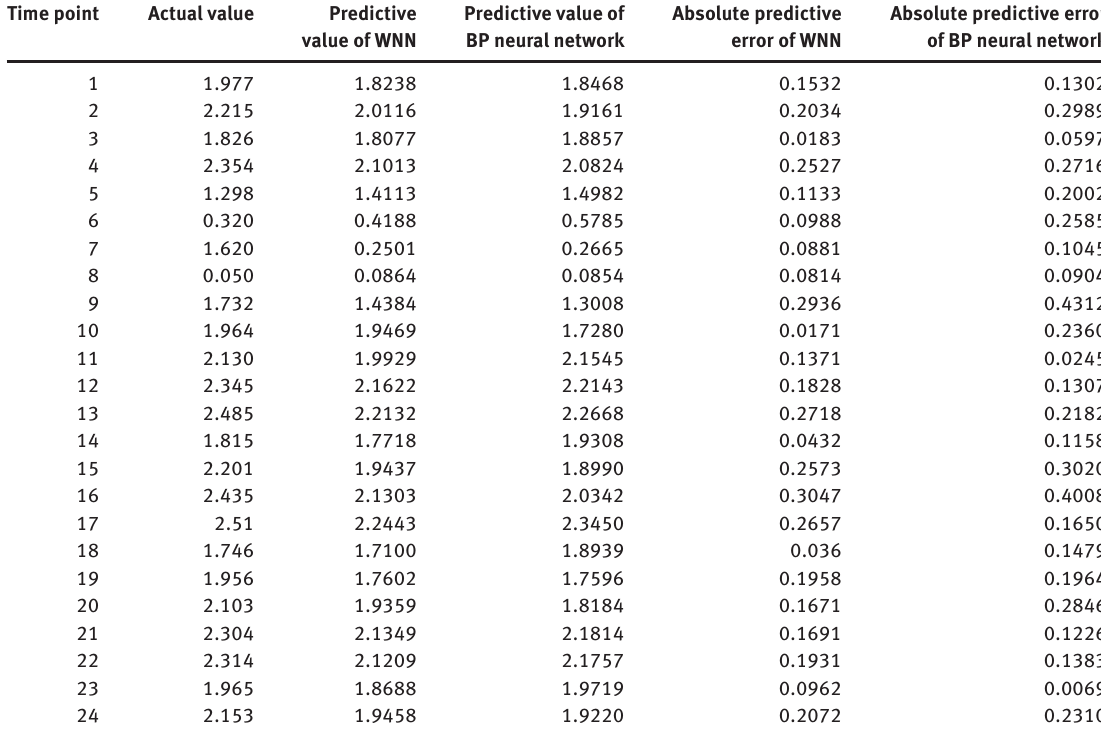
Table 1. Numerical Results of